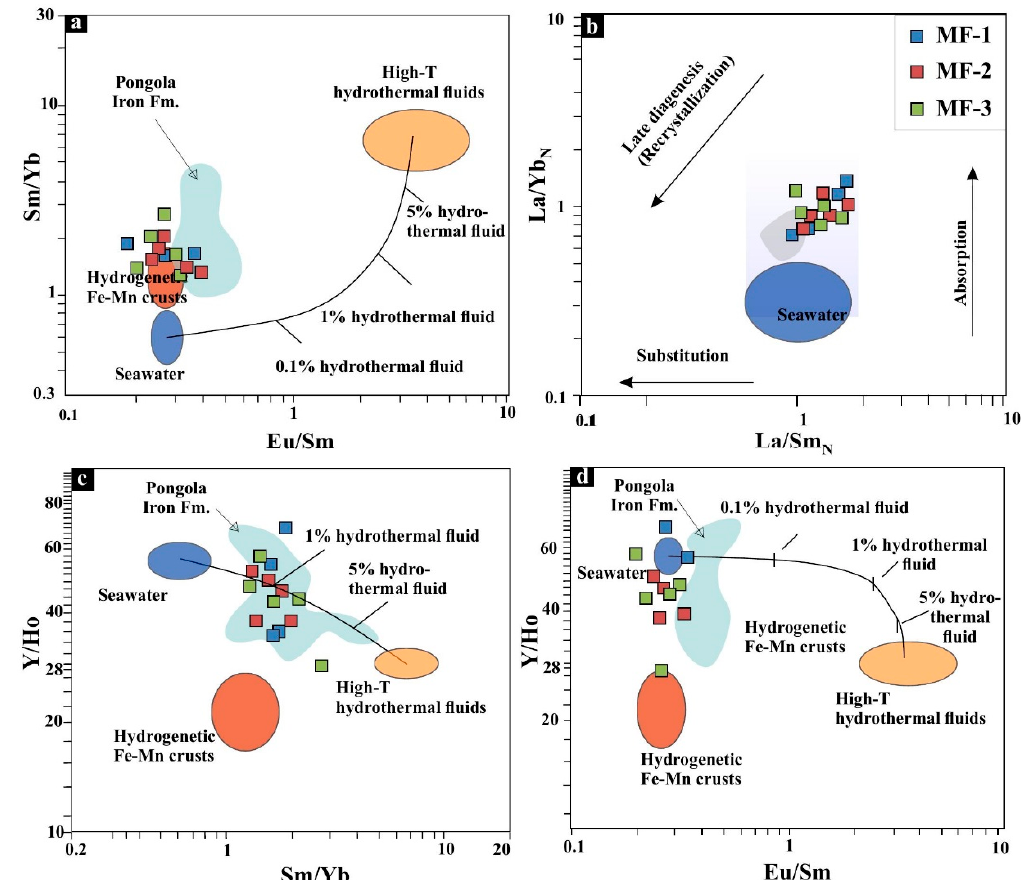
Figure 9. Plots of the Eu / Sm vs. Sm / Yb ( a ); (La / Sm)N vs. (La / Yb)N ( b ); Sm / Yb vs. Y / Ho ( c ); and Eu / Sm vs. Y / Ho ( d ) [21,71,115].